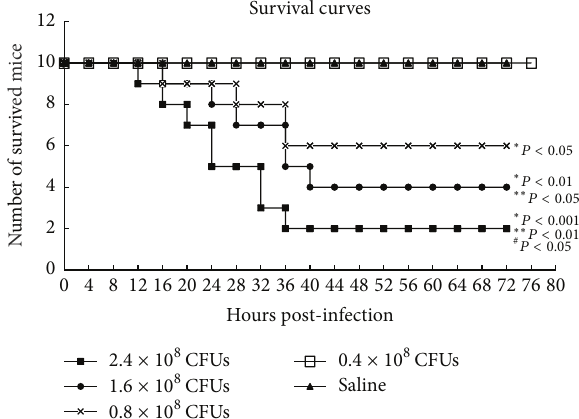
Figure 1: Survival curves of mice with septic peritonitis induced by E. coli . ICR mice were infected intraperitoneally with E. coli at different doses for inducing septic peritonitis. Saline-injected mice were as controls. The survival of the mice was counted. ∗ Compared to control mice; ∗∗ compared to mice infected with 0.4 × 10 8 CFUs of E. coli ; # compared to mice infected with 1.6 × 10 8 CFUs of E. coli